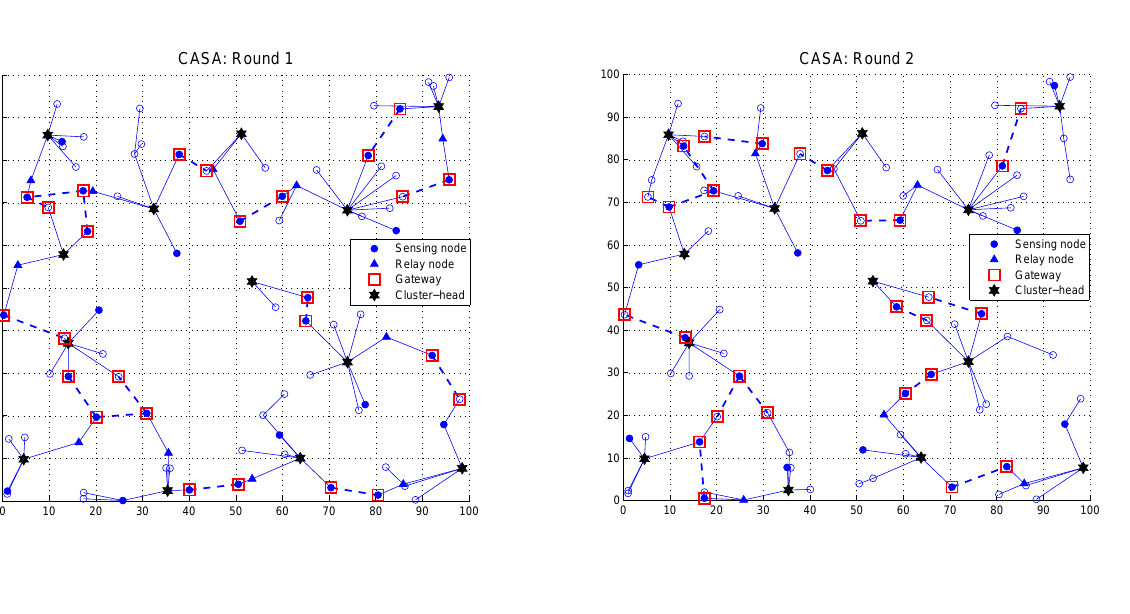
Figure 21. The network connectivity using the CASA scheme in round 1 (left) and round 2